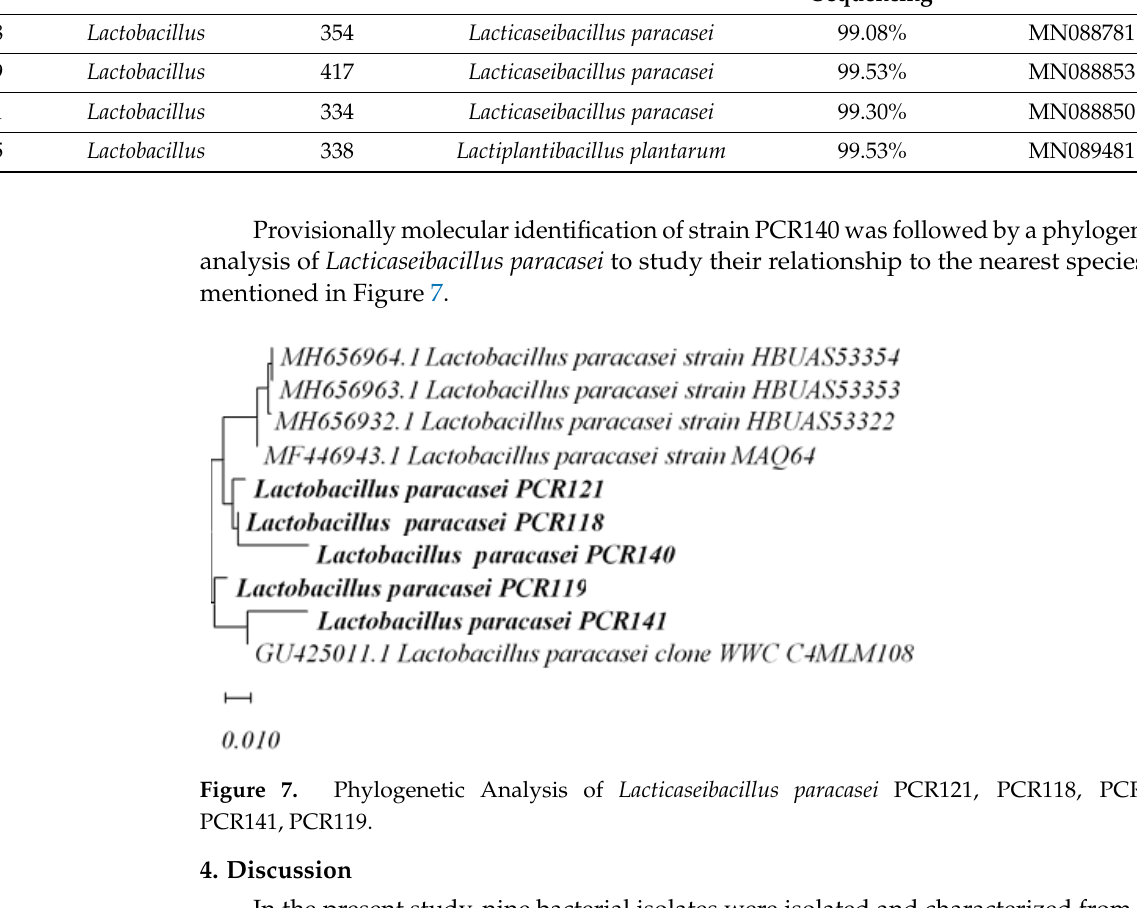
Table 4. Provisionally Taxonomy of Bacterial Isolates.